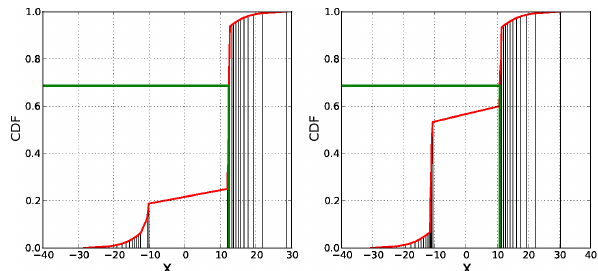
Figure 6. Illustration of the MRHF analysis step for the first un- observed variable (one particle): red lines represent the cumulative (x) (left panel) distribution functions (cdf) of the prior density p b i (x) (right panel). The vertical black and the posterior density p a i lines show the selected particles used to build these densities. To compute the x analysis value for the prior x particle near 11 on the left panel, the green line must be followed: the cdf for the prior x is computed with the prior cdf (Result is near 0.68); from this cdf value, the x analysis value is obtained on the right panel; see text for (x) ; see i